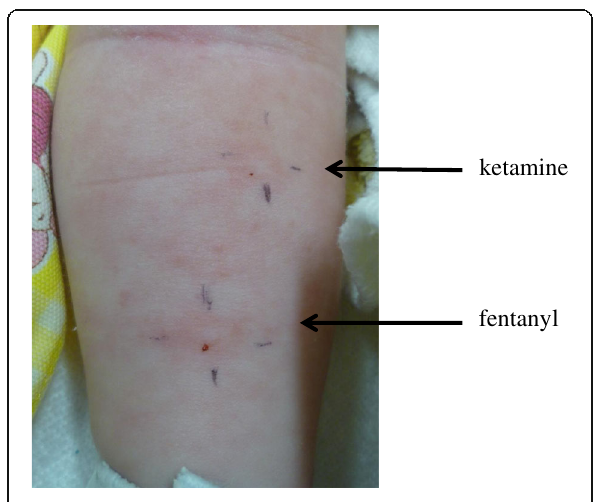
Fig. 1 Positive flare response to intradermal